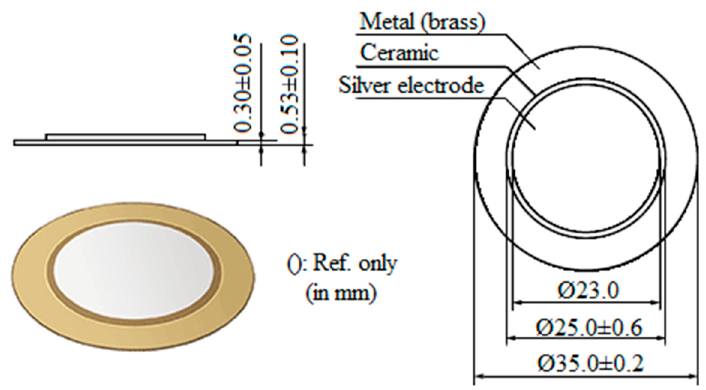
Figure 1. Murata piezoelectric sensor 7BB-35-3 used in the tests.